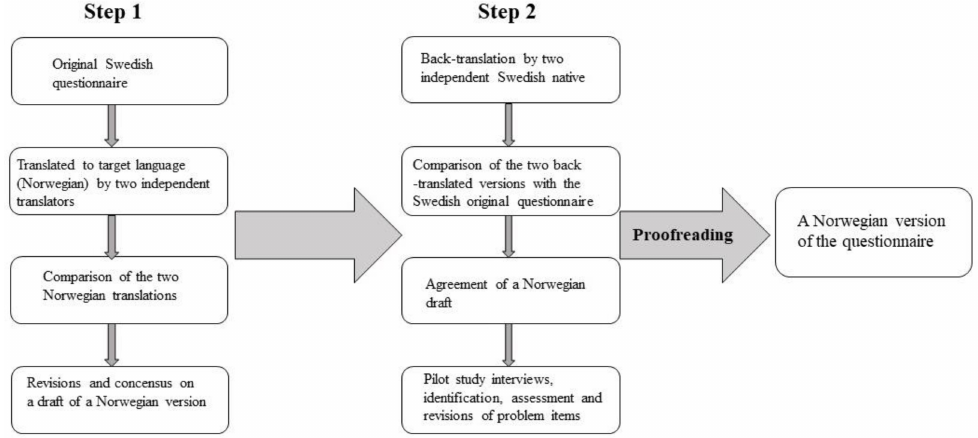
Figure 1. Translation process of the Swedish study-specific